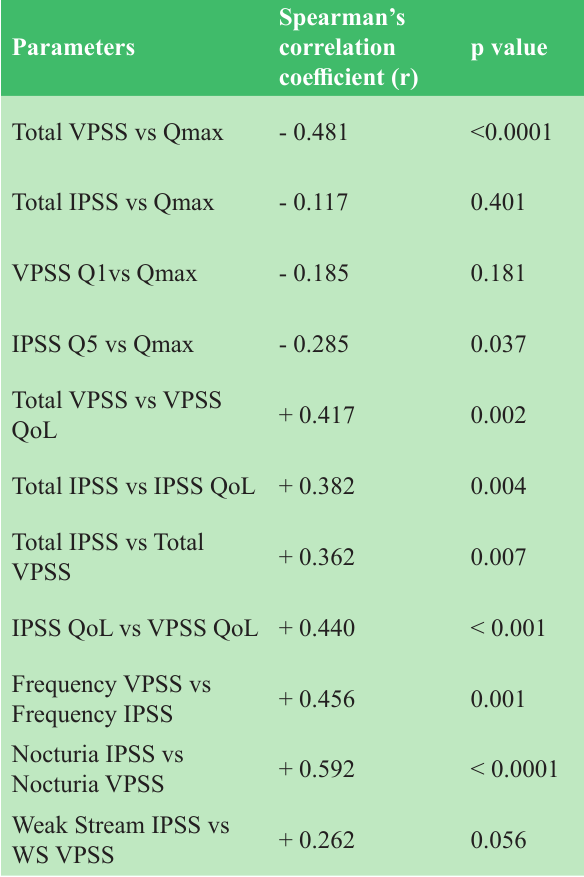
Table 3. Spearman’s correlation for IPSS and